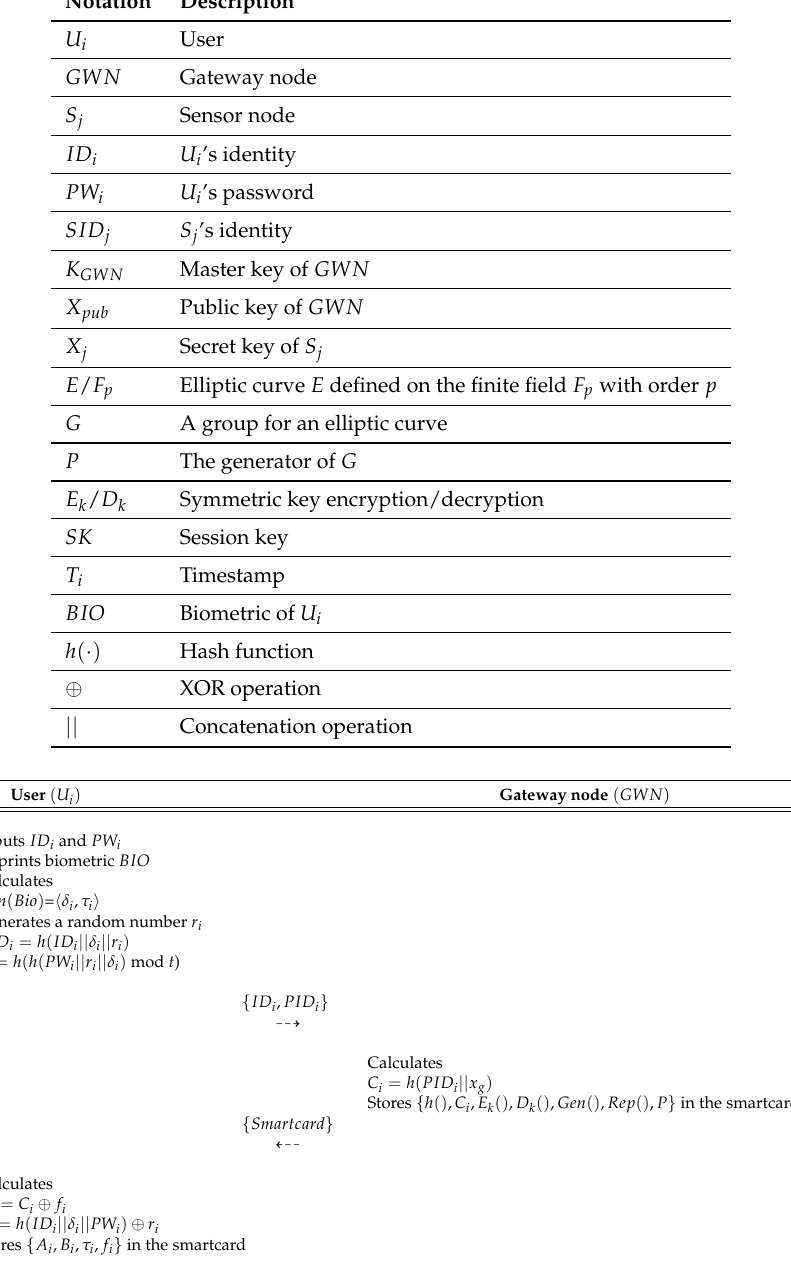
Figure 2. Registration process of Mo and Chen’s